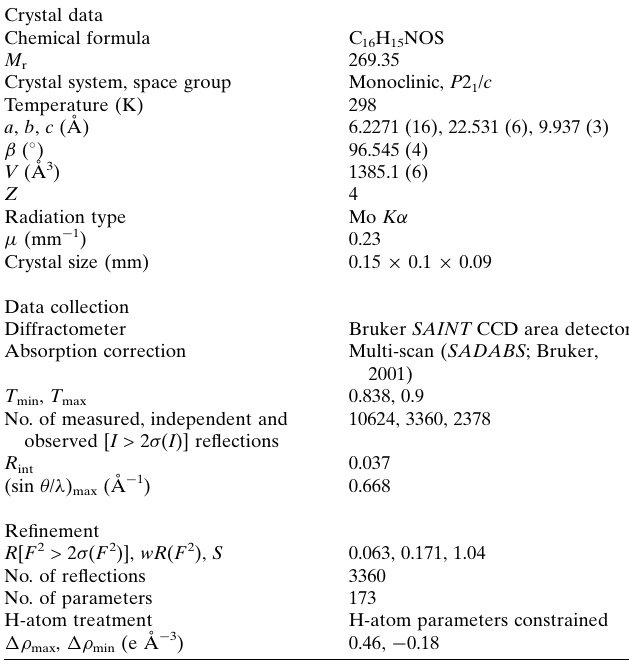
Table 1 Hydrogen-bond geometry (A˚ , (cid:2) ).